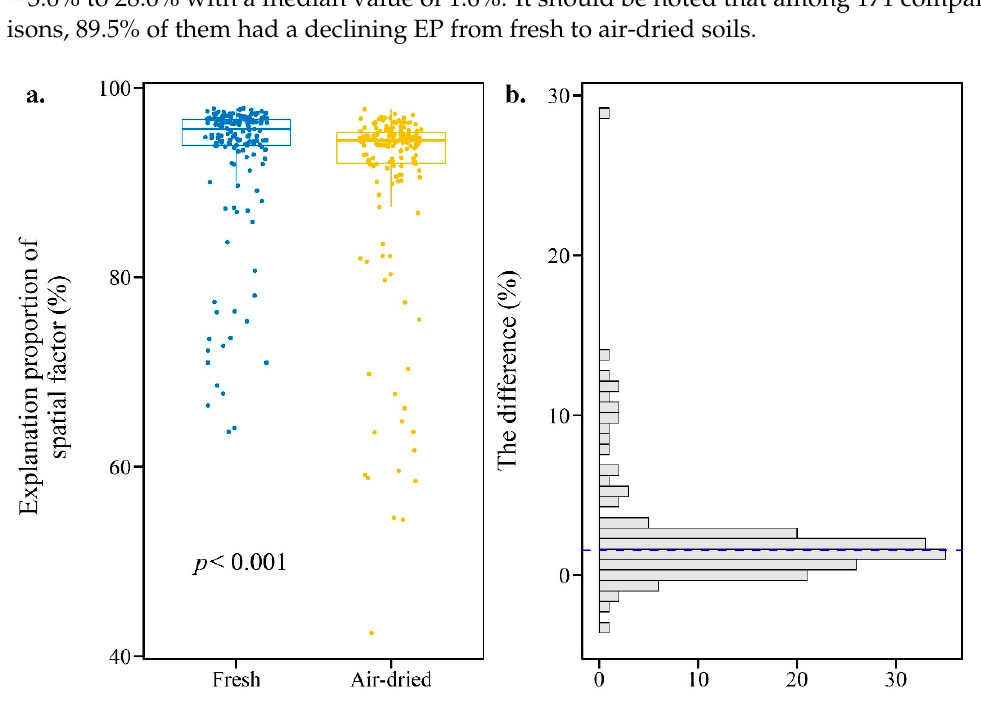
Table 1. Variation in NDEP values at different spatial scales and environmental difference scales.